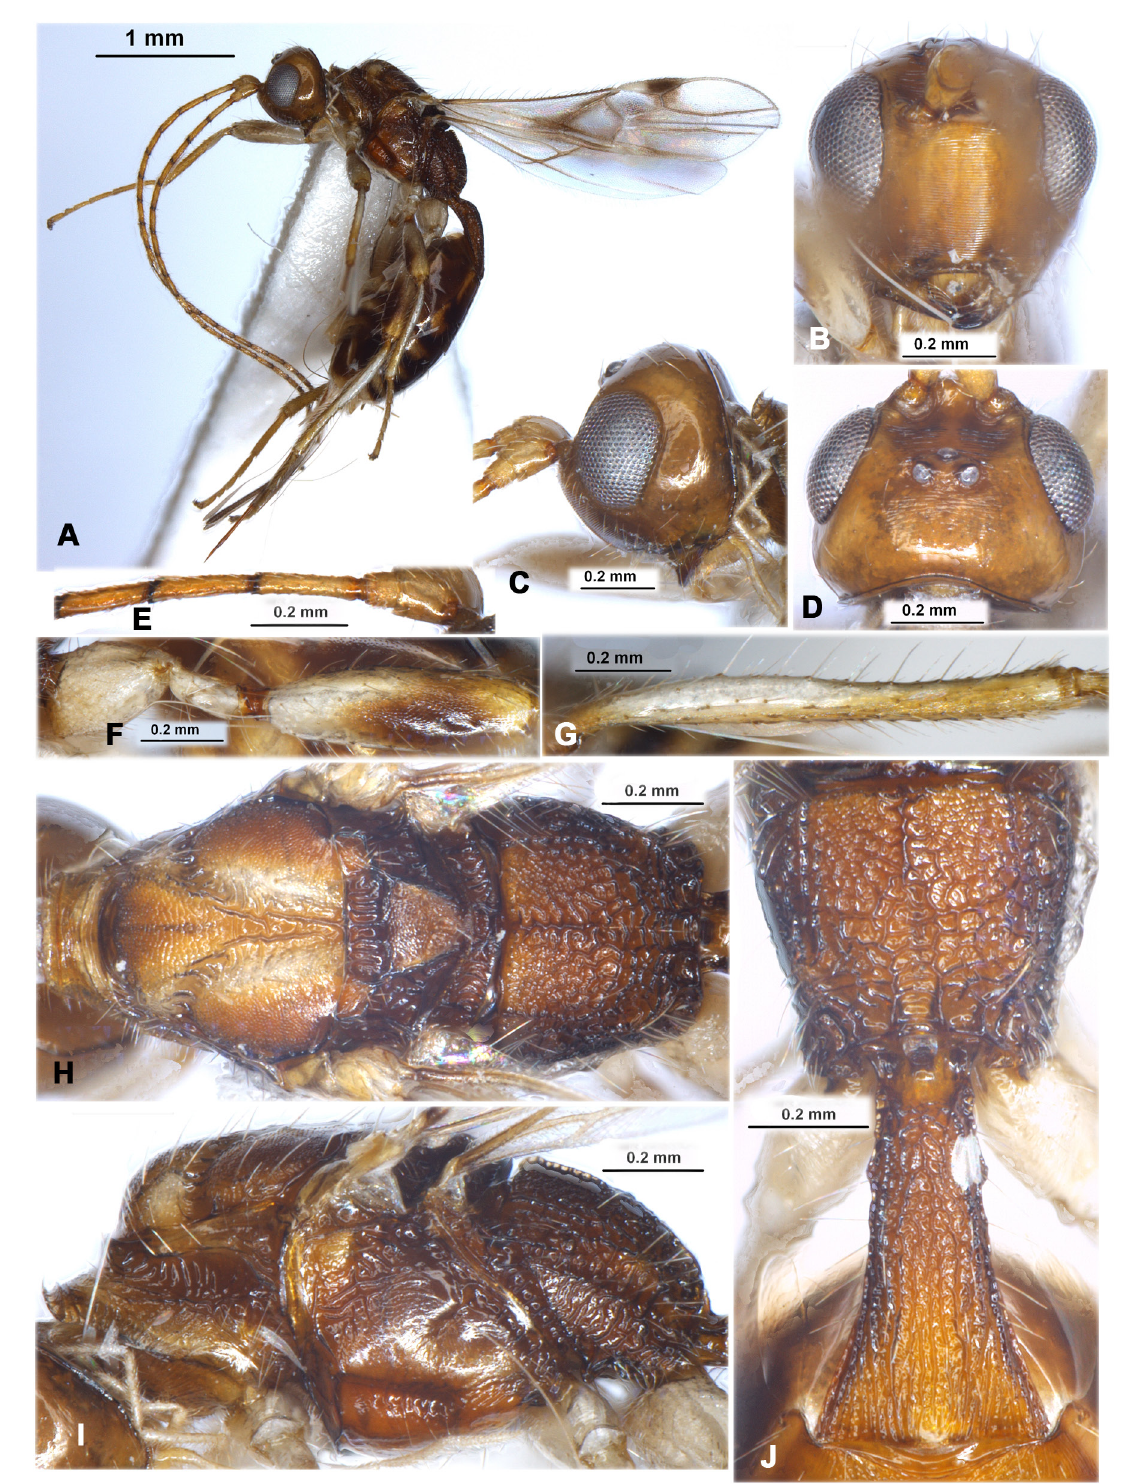
Fig. 24. Spathius subafricanus Belokobylskij sp. nov., holotype, ♀ (RMNH). A . Habitus, lateral view. B . Head, front view. C . Head, lateral view. D . Head, dorsal view. E . Basal segments of antenna. F . Hind coxa and femur. G . Hind tibia. H . Mesosoma, dorsal view. I . Mesosoma, lateral view. J . Propodeum and petiole of metasoma, dorsal